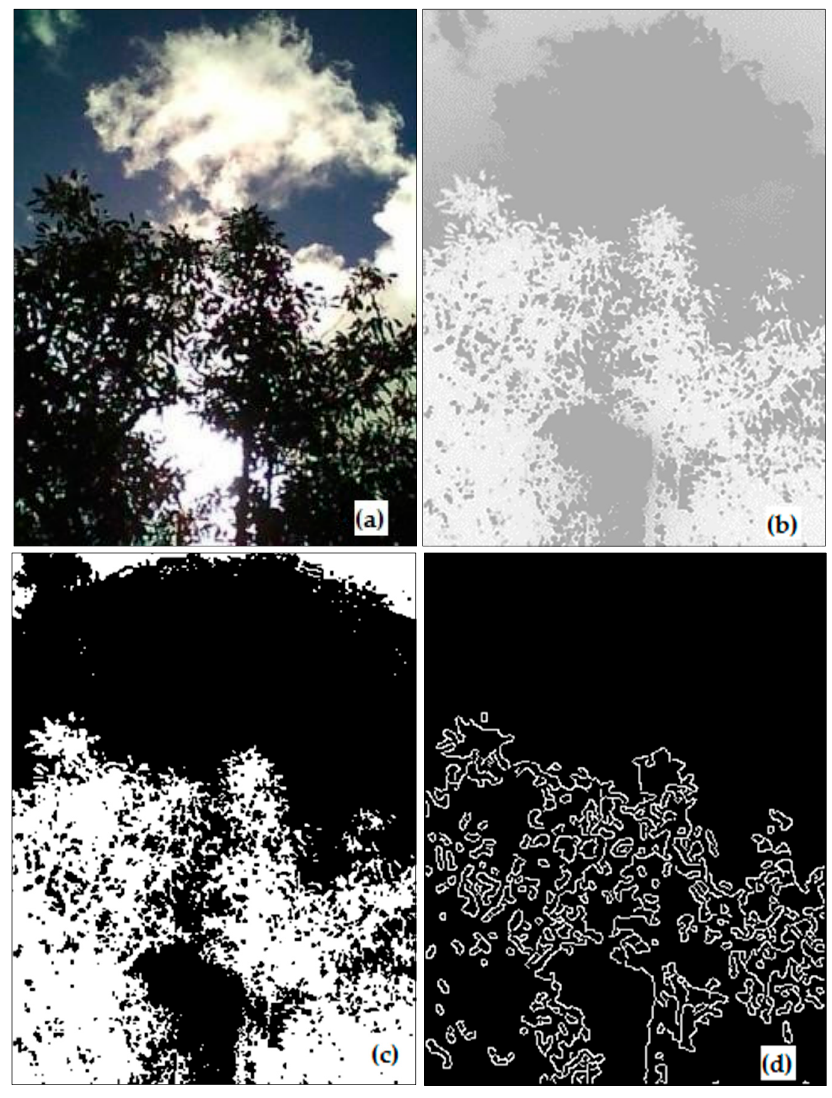
Figure 2. Example for stages during image analysis; ( a ) original image (RGB), ( b ) mono-colour image by inversing, ( c ) colour segmented by Otsu’s, and ( d ) edge detection by Canny method.